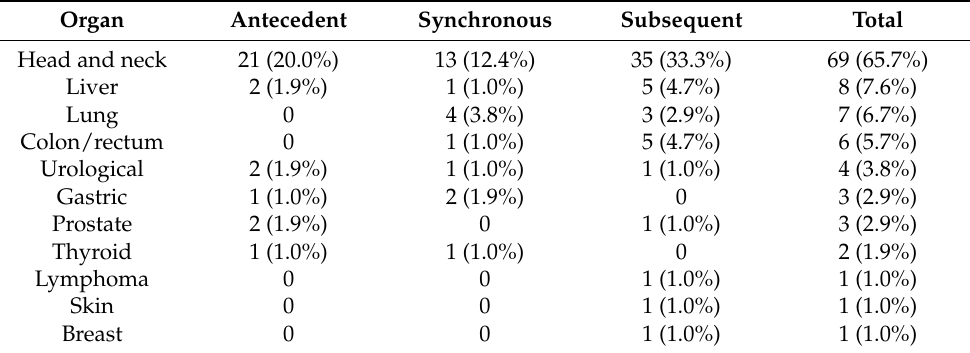
Table 3. Distribution of multiple primary